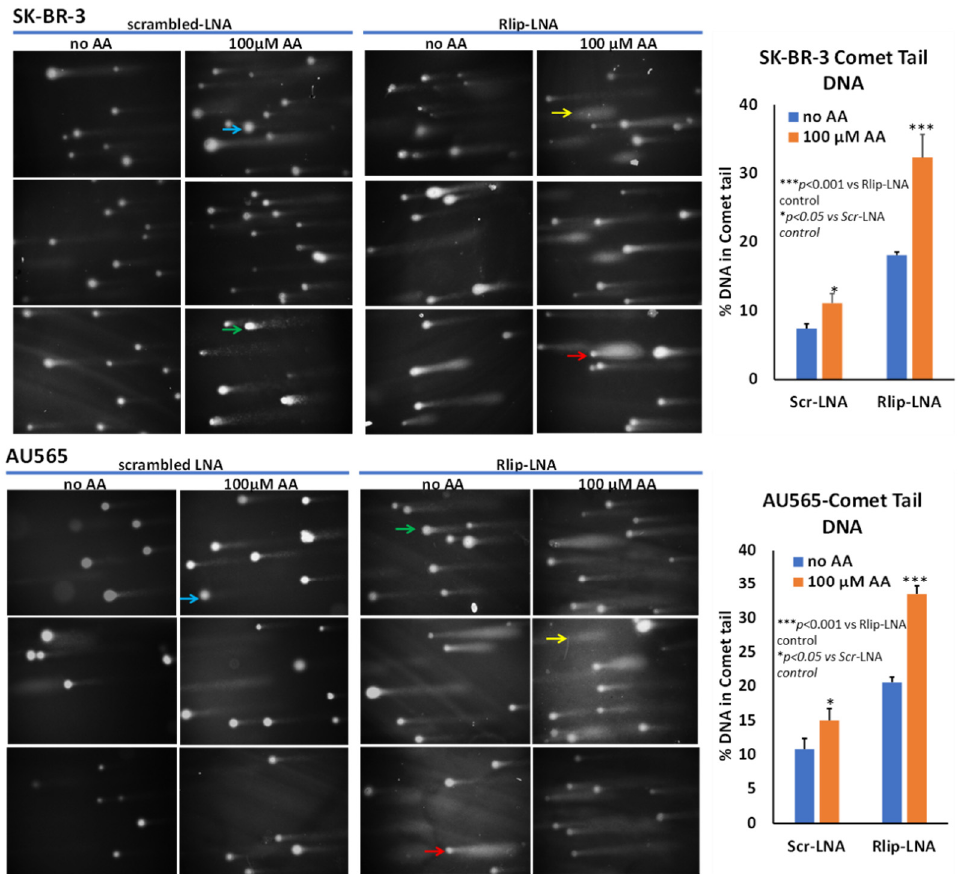
Figure 6. Effect of AA after Rlip-LNA on DNA fragmentation in SK-BR-3 and AU565 cells by comet assay. Representative images at 200× magnification of alkaline comet assays from control, and 100 µM AA-treated SK-BR-3 and AU565 cells with or without Rlip knockdown. Blue arrows point to cells with enlarged nuclei with minimal damage and a faint tail; green arrows point to typical comet appearance; red arrows point to ‘hedgehog’ comets; and yellow shows only a cloud of fragmented DNA. Image J was used to quantify the intensity of the DNA tail defined to the right of the nucleus regardless of shape. A two-tailed unpaired Student t -test was used to calculate the significance.